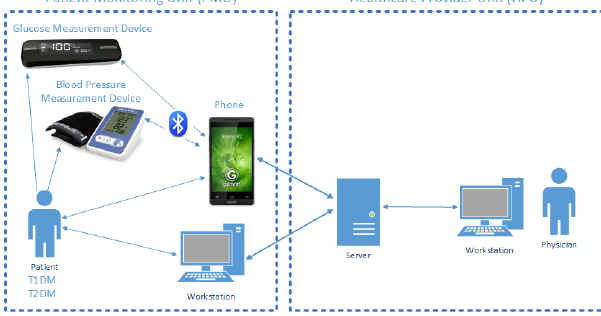
Figure 1. Telemedicine system architecture combining